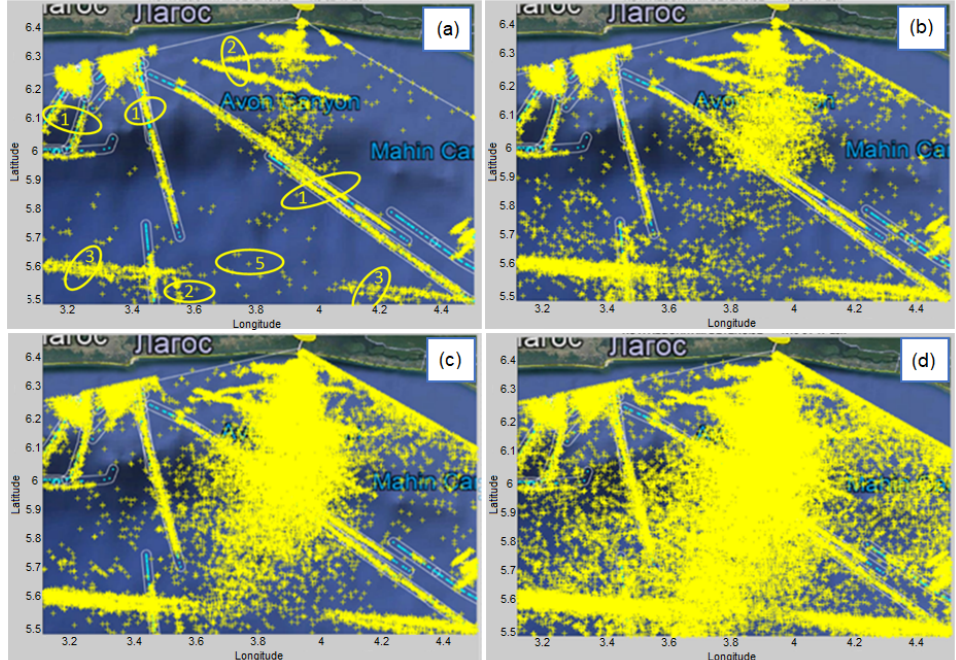
Figure 19. The display of all vessel’s detections (yellow markers) in a small part of the area, with AIS data as a benchmark (light blue tracks) in a time interval of 5 h for different detection parameters of the proposed algorithm: ( a ) K = 5 and normalized threshold = 0.2 ( b ) K = 5 and normalized threshold = 0.1 ( c ) K = 10 and normalized threshold = 0.2 ( d ) K = 10 and normalized threshold =